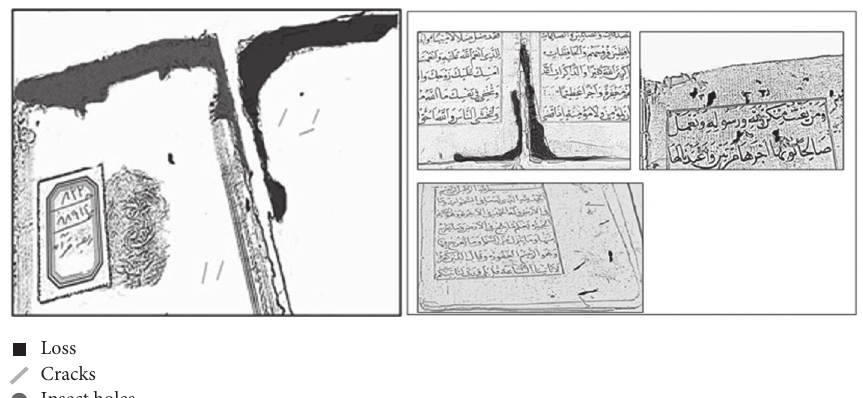
Figure 2: Documentation of the leather cover of manuscript on photoshop.